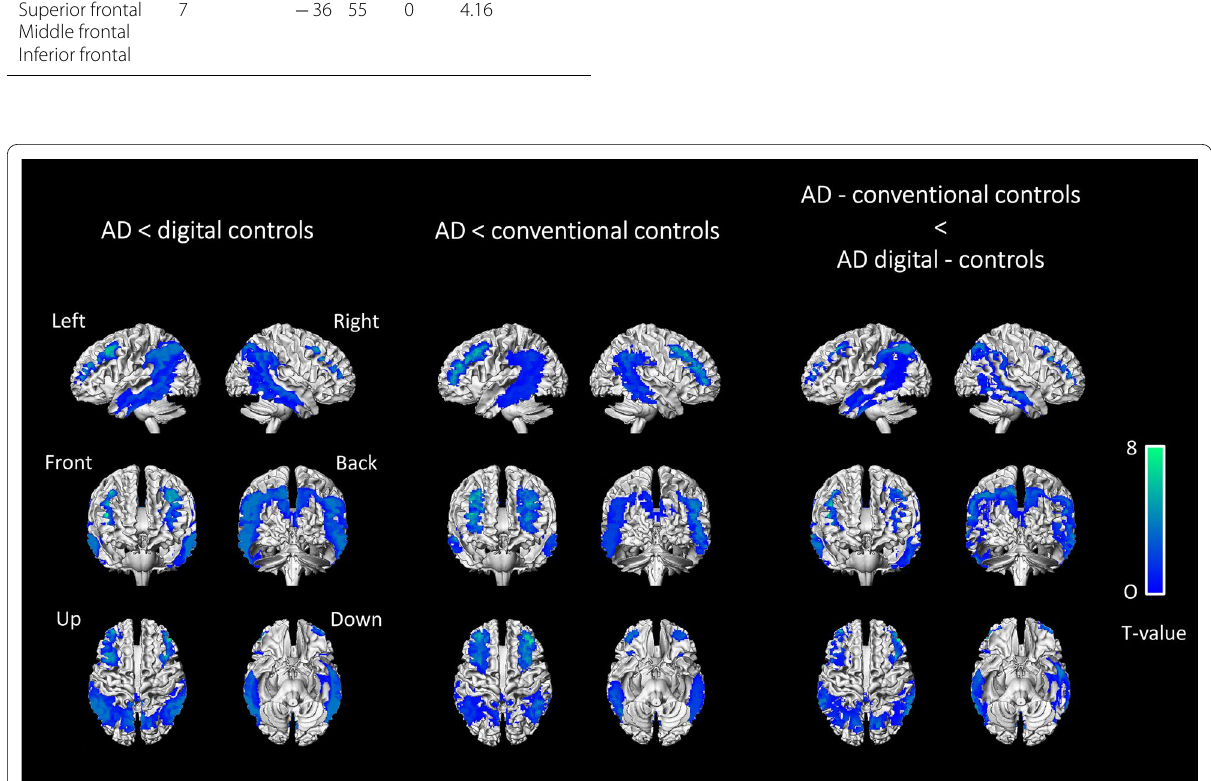
Fig. 2 Anatomical localisation of areas of decreased metabolic activity in AD patients ( p < 0.001, uncorrected, k > 1.86 cm 3 ) for SQA using digital controls (left panel), SQA using conventional controls (middle panel), and the significant additional hypometabolic areas obtained with SQA using digital controls compared to SQA using conventional controls (right panel), projected onto 3D volume rendering, spatially normalised and smoothed into the standard SPM template (T‑voxel threshold value of